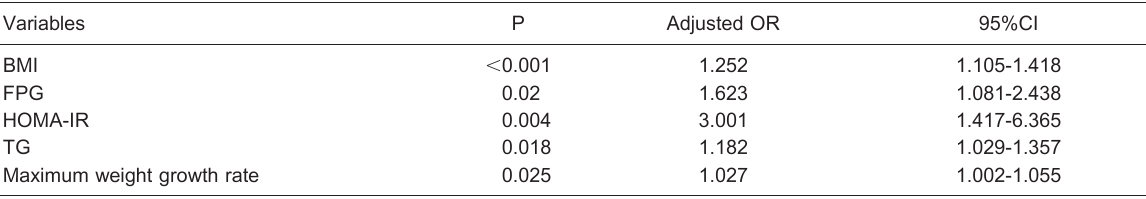
Table 3. Independently associated factors of nonalcoholic fatty liver